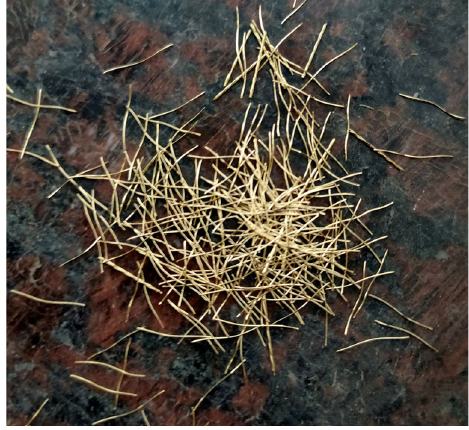
Figure 2. Straight copper- coated steel fibers.